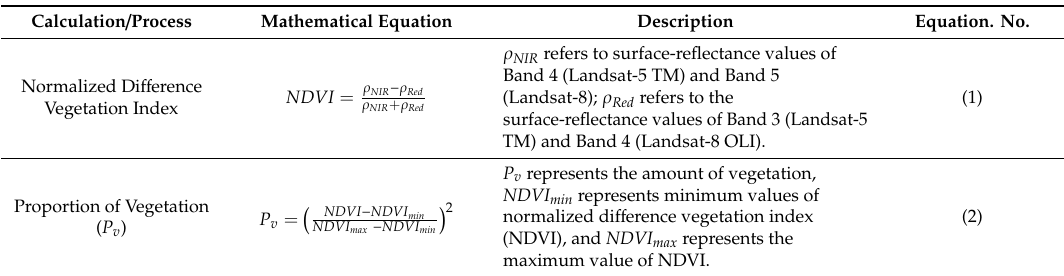
Table 2. Land-surface temperature (LST) calculation process with equation descriptions. Calculation /